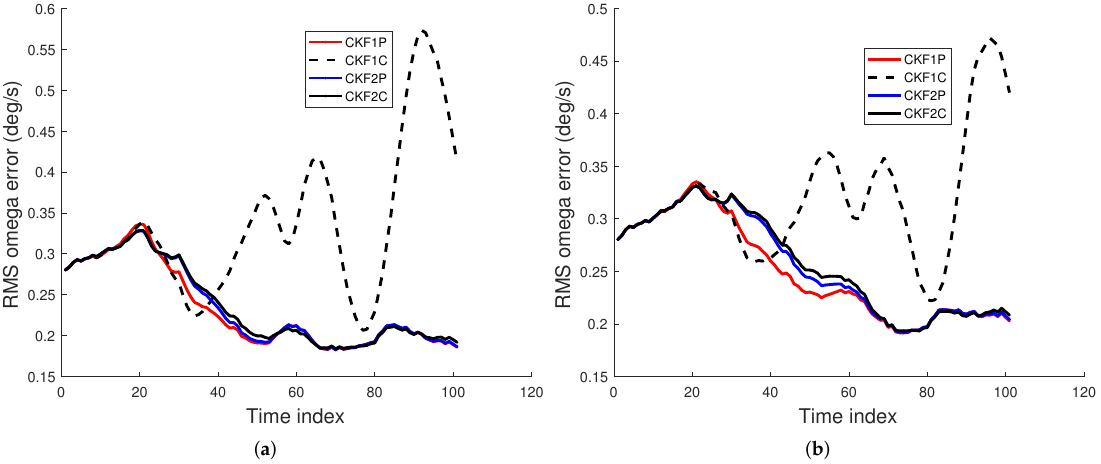
Figure 7. RMS angular rate error using the prior variance P 0,p,1 from 500 Monte Carlo runs. ( a ) Angle SD of 1 mrad, ( b ) Angle SD of 2